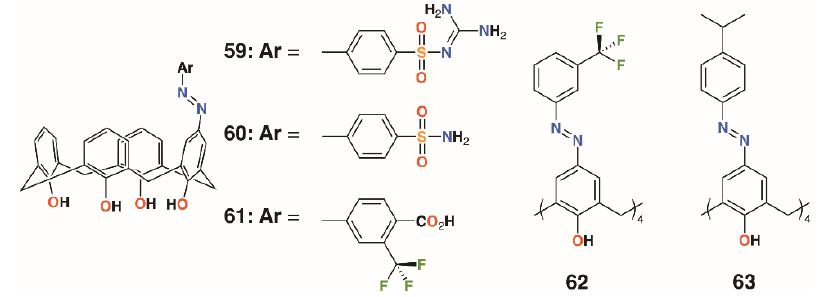
Figure 11. Hamid’s sulfonamides and related compounds.